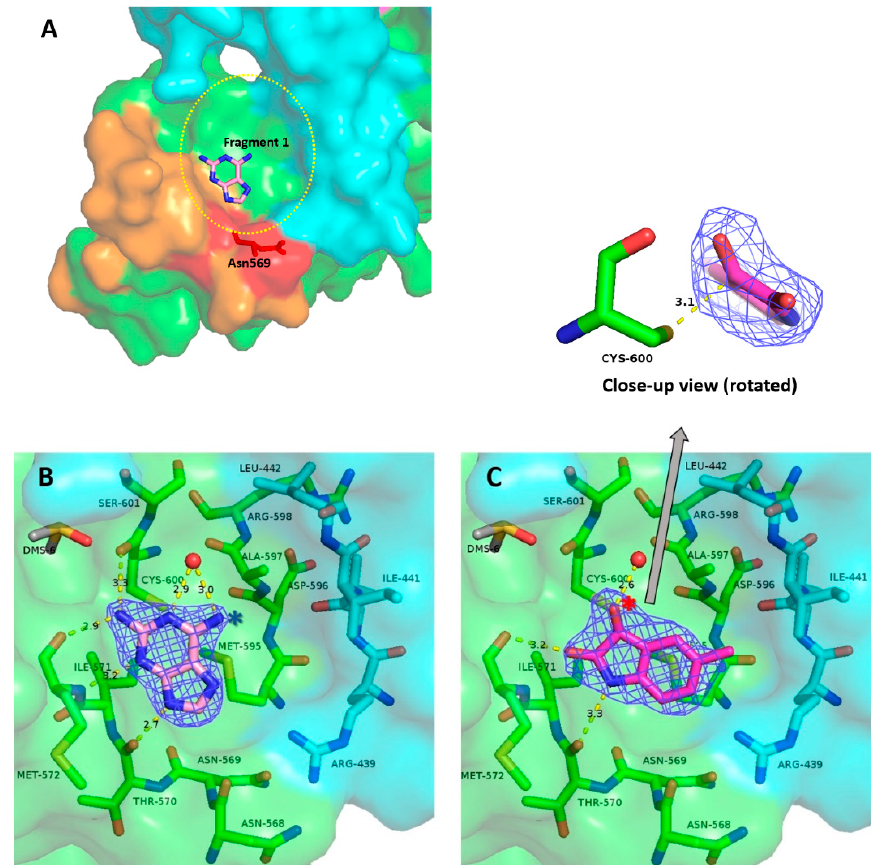
Figure 2. Fragment-binding site A. ( A ) Overall view of the binding pocket shown as a solvent- accessible surface with fragment 1 in place. The rim of the pocket is approximated by an oval (yellow dotted line). The surface of residues 565 to 584 is colored orange. Residues Asn568, Asn569,